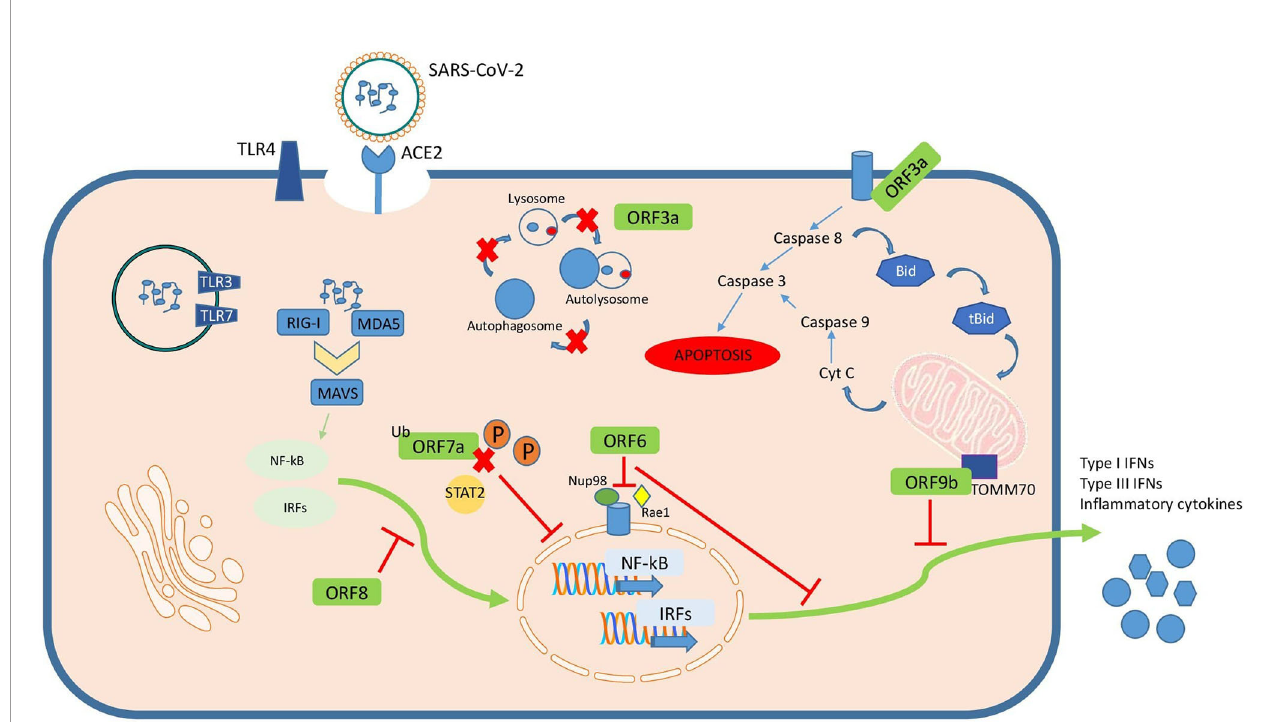
FIGURE 2 | Summary of SARS-CoV-2 accessory proteins known mechanisms of action in the infected